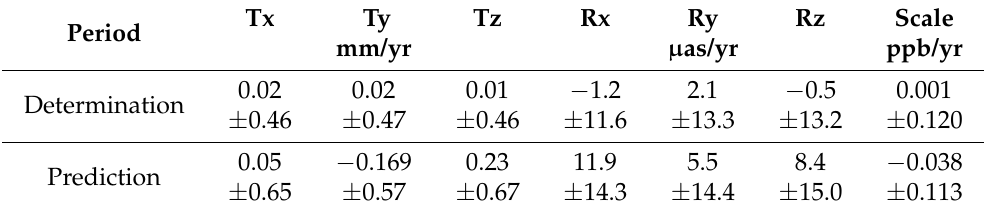
Table 1. The trends and standard deviations of the transformation parameter time series estimated between ITRF2014 and IGS before and after 14 February 2015. Note: the standard deviation of scale was the result after the annual signal with an amplitude of 0.25 ppb